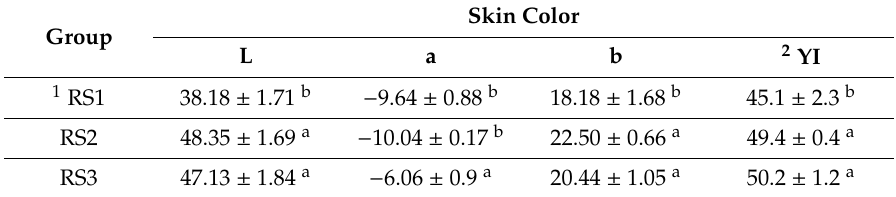
Table 1. The change in skin color of Shine Muscat grape berries at di ff erent ripening stages.